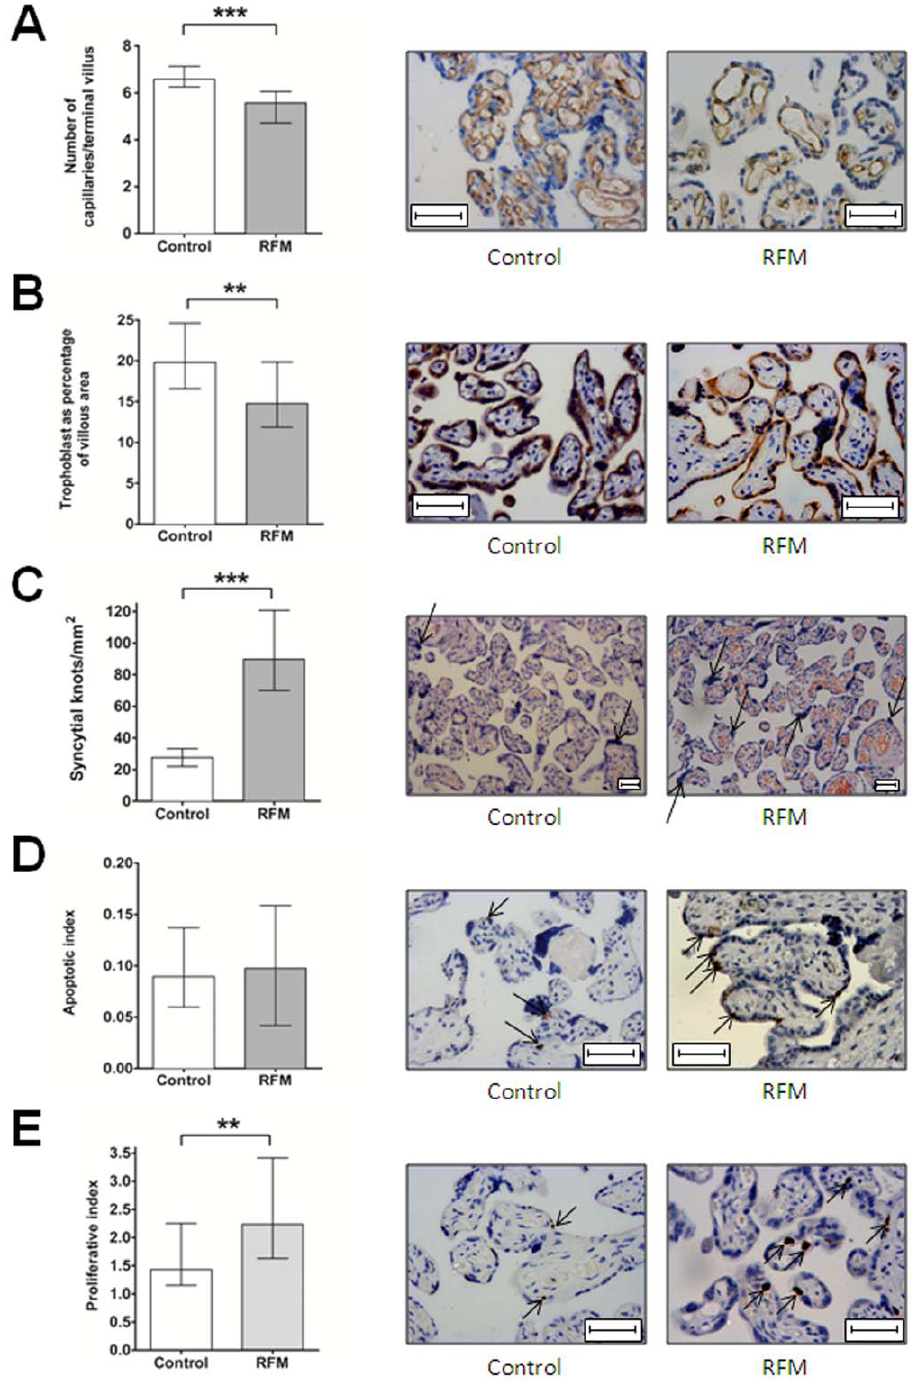
Figure 2. Microscopic structure of RFM placentas compared to control pregnancies. A) RFM placentas have significantly decreased villous vascularity (*** p , 0.001, Mann-Whitney U test). Representative micrographs of CD31 immunostaining. B) In RFM, the placenta has significantly reduced trophoblast area compared to control placentas (**p , 0.01, Mann Whitney U Test). Representative micrographs of CK7 immunostaining. C) Density of syncytial knots is increased in RFM (*** p , 0.001, Mann-Whitney U Test). Representative images from haematoxylin and eosin staining, syncytial knots are marked with arrows. D) There is no significant difference in cell death through apoptosis in RFM compared to control placentas. Representative images from M30 staining; M30 staining is marked with arrows. E) Proliferative Index is increased in RFM (**p , 0.01, Mann-Whitney U Test) Representative images from Ki67 immunostaining (Mib1 antigen). Positive nuclei are marked with arrows. In all photomicrographs bar=50 m m.